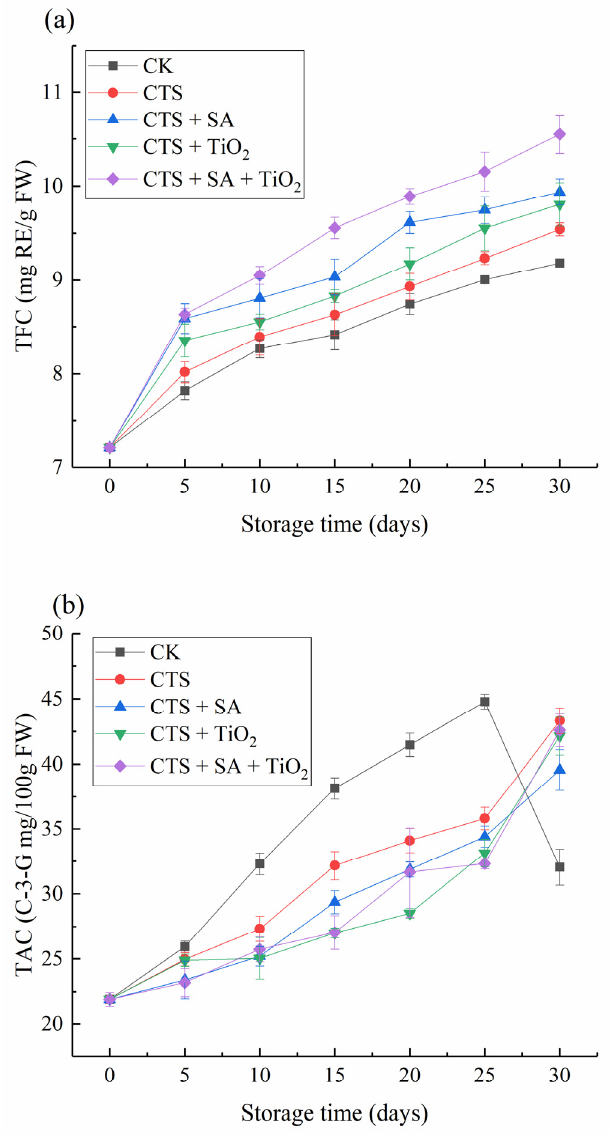
Figure 5. Total flavonoid content ( a ), anthocyanin content ( b ) of the samples during 30-day storage at 4 °C. Anthocyanins are a group of phenolic compounds responsible for the red-blue color of many fruits and vegetables, which provide beneficial effects for human health [71].